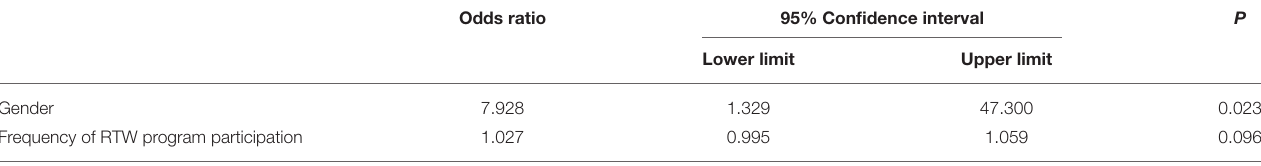
TABLE 2 | Cox regression analysis of maintaining restoration.